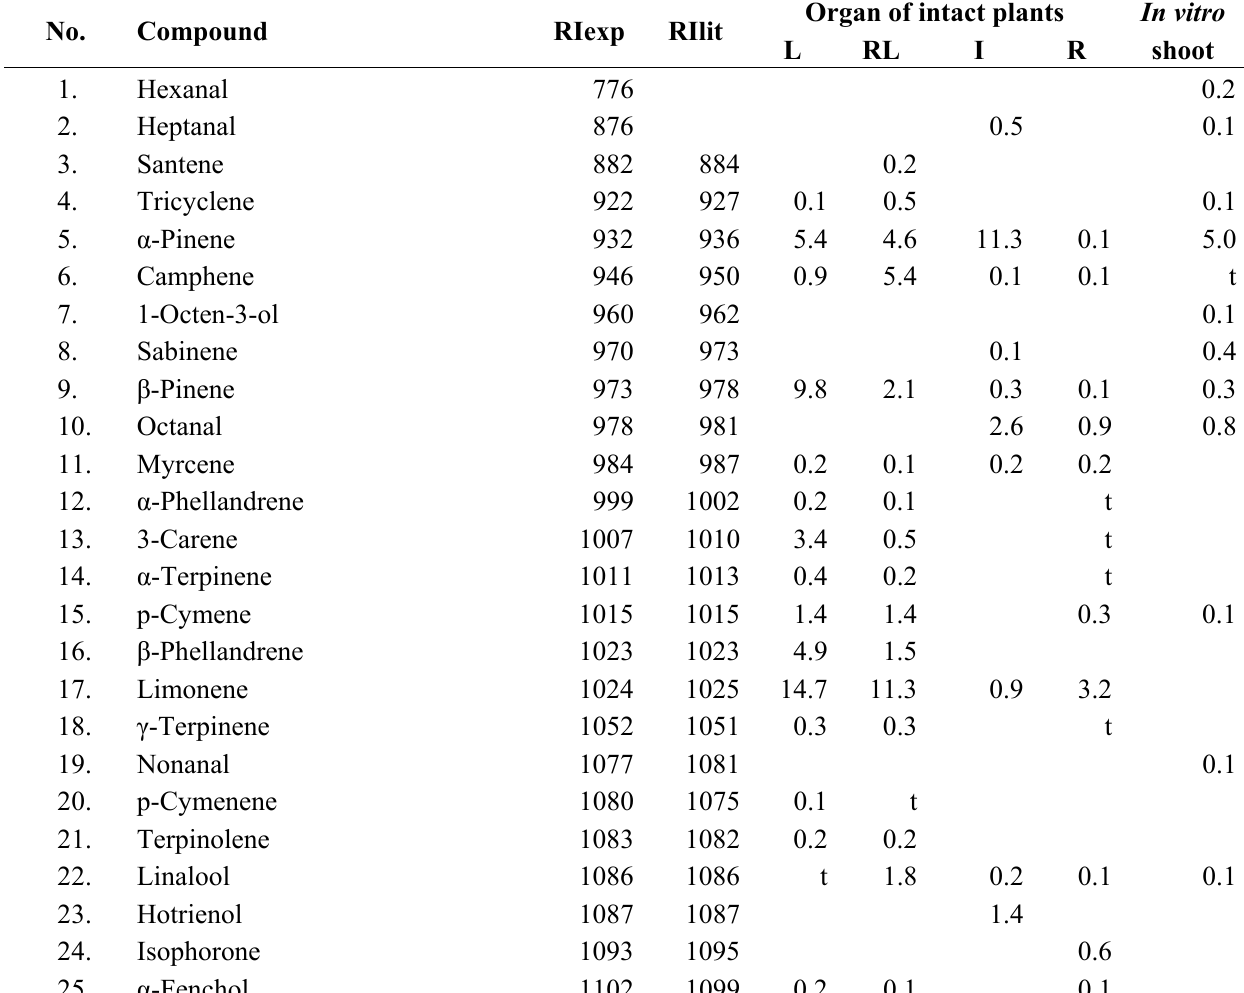
Table 1. Chemical composition (%) of essential oil from different organs of intact plants and in vitro shoot culture of Eryngium planum